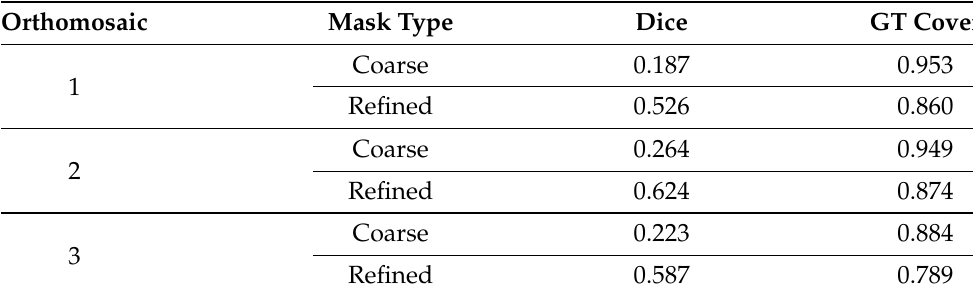
Figure 8. Orthomosaic B1 is displayed with a combination of the manual annotations (black marked spots), the coarse mask (dark grey) and the refined mask (light grey). The red box was zoomed in to show a detailed view on the image and masks. Table 3. Numerical evaluation of the refinement step of the DNN. The rows marked "refined" stand for the algorithm after refinement, while the rows marked "Coarse" correspond to the algorithm without refinement for each of the three studied orthomosaics. The Dice coefficient, as well as the ratio of blueberry pixels in the Ground truth covered by each of the two masks, are